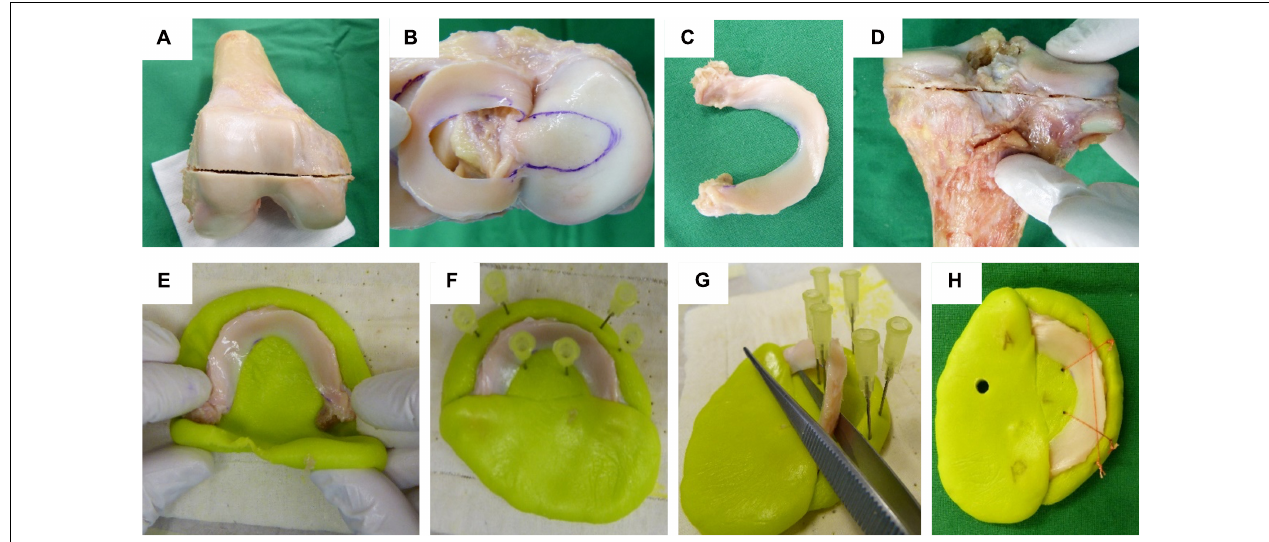
FIGURE 1 | Human cartilage and meniscus sample preparation: (A) Horizontal plane cut at the distal femur. (B) Highlighting the cartilage-to-cartilage contact area at the tibial plateau using a permanent tissue marker. (C) Separated lateral meniscus with its intact anterior and posterior root attachments. (D) Horizontal plane cut at the proximal tibia. Meniscus cast preparation steps: (E) The meniscus was initially embedded at a time point when the polymethylmethacrylate (PMMA) had a rubber-like texture. (F) Insertion of six needles to allow for a later positioning of security sutures. (G) During the exothermic hardening reaction of the PMMA, the meniscus body was temporarily removed. (H) Final meniscus sample including interlinked security sutures and anterior ( A ) and posterior ( P ) cast markings.